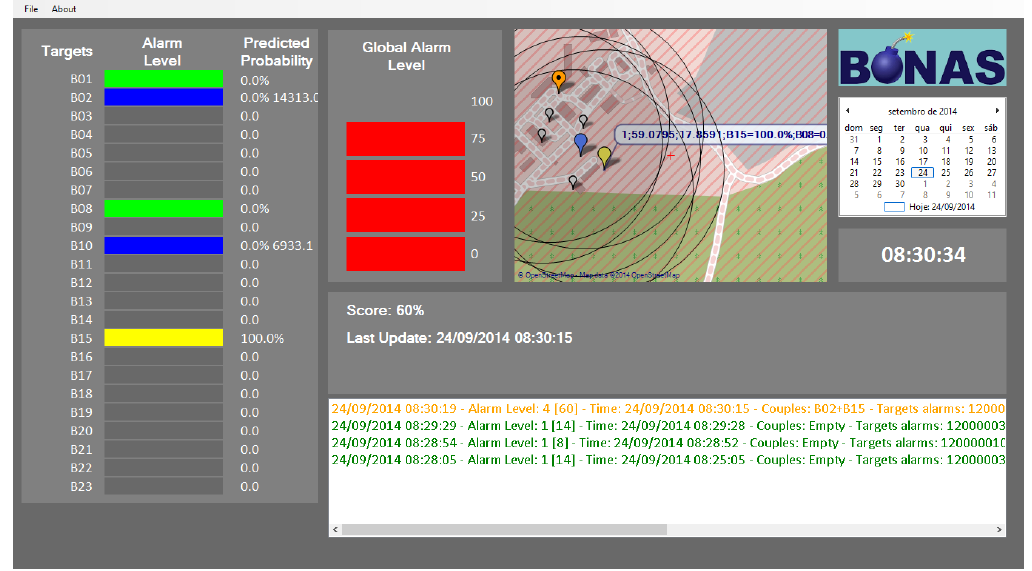
Figure 8. Example of a user interface obtained during the test campaign at FOI, which shows the positive detections for three targets obtained by two sensors. Since a couple of target detected is known to be used together for the preparation of one IE, the global alarm has increased above the threshold of 50.